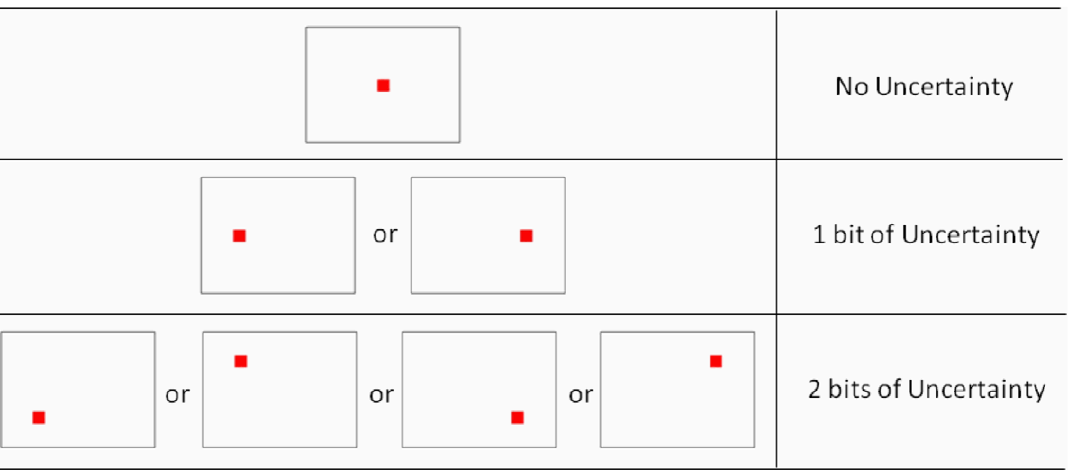
Figure 1. Illustration of the 3 different spatial uncertainty conditions. When there is no uncertainty, the stimulus always appears in the center of the screen.